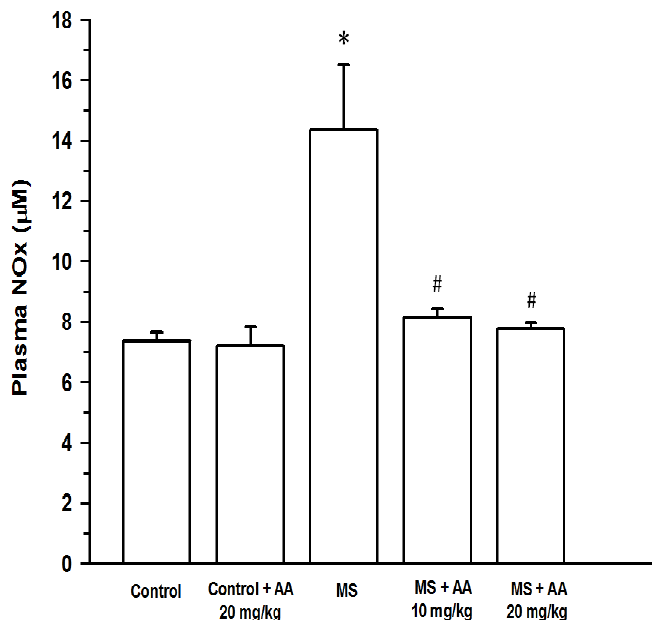
Figure 4. Effect of asiatic acid on plasma nitric oxide metabolites (NOx) in all experimental groups. Results are expressed as mean ± SEM. AA represents asiatic acid.